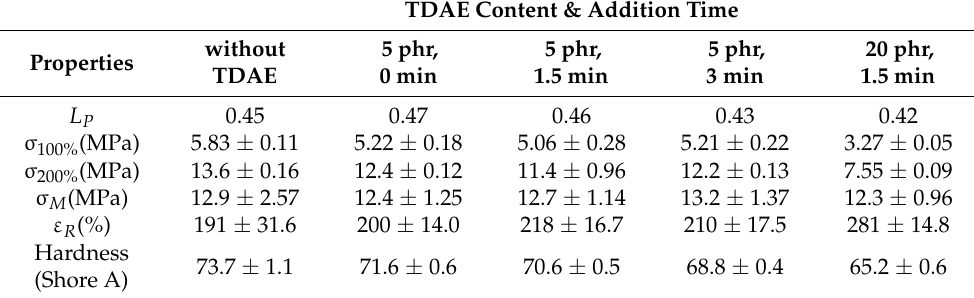
Figure 8. Storage tensile modulus ( E ′) ( a ); and loss tensile modulus ( E” ) ( b ) of silica-filled SBR/BR vulcanizates depending on TDAE content and addition time. The analyses were carried out with 10 Hz frequency and at 60 °C. Table 2. Rubber layer L P values of silica-filled SBR/BR binary blends and mechanical parameters of the binary vulcanizates. TDAE Content & Addition